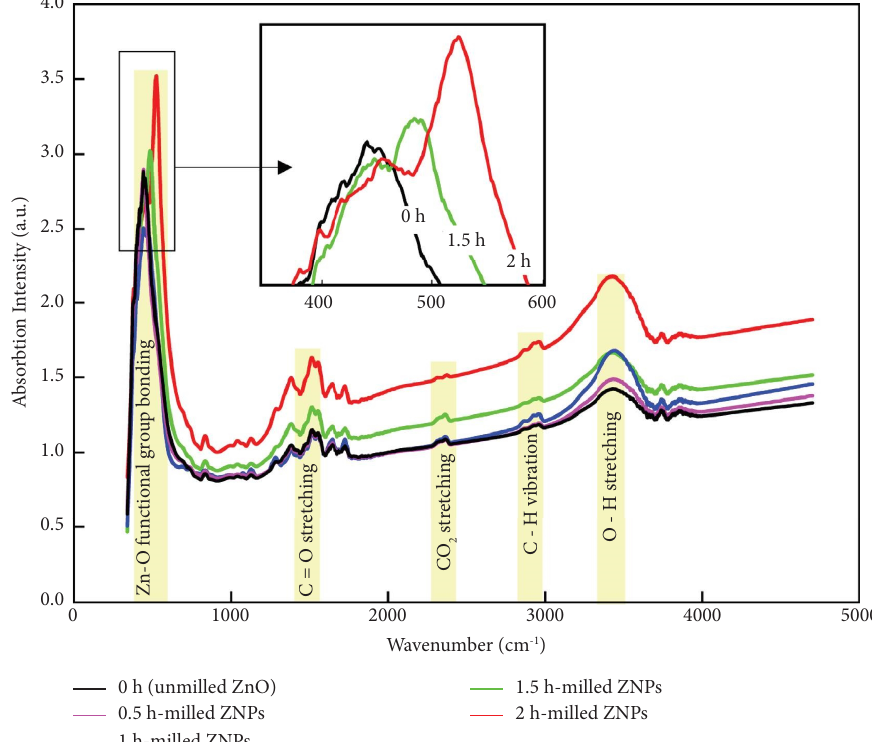
Figure 5: Te FT-IR spectra of ZnO milled at diferent ball-milling